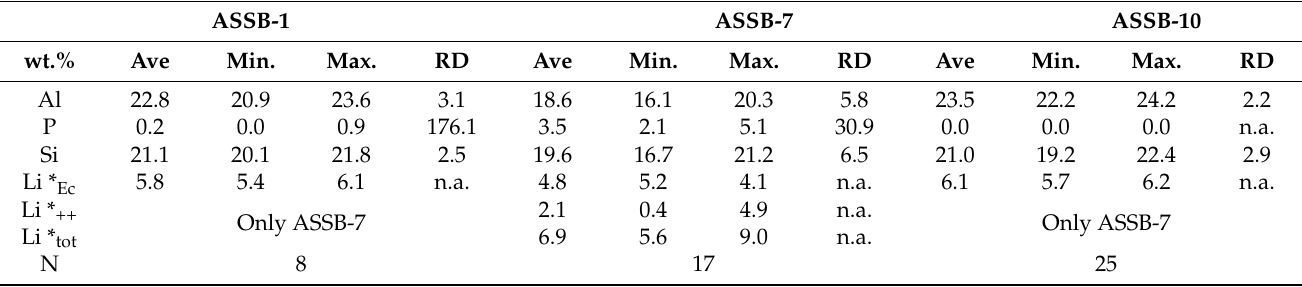
Table A4. Composition of Ec (Ec(P)) (wt.%) based on single-point analysis. Ave.: arithmetic average, Min./Max.: lowest/highest measured values; RD: relative standard deviation (%); * calculated value; Li * Ec : Ec portion; Li * ++ : Li excess; Li * tot : total calculated Li; N: number of measurements; n.a. not applicable (calculated